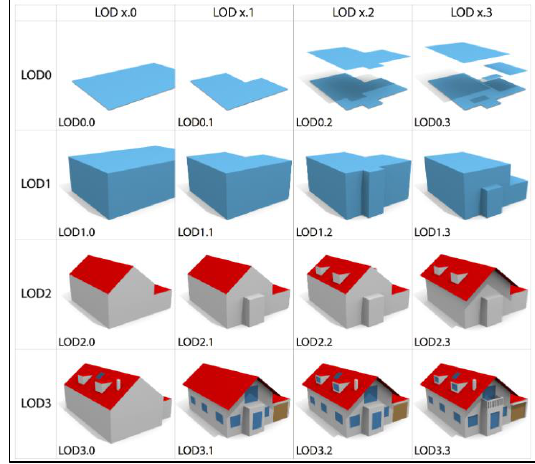
Figure 1. Revised LoD model for CityGML. Image taken from Biljecki et al.